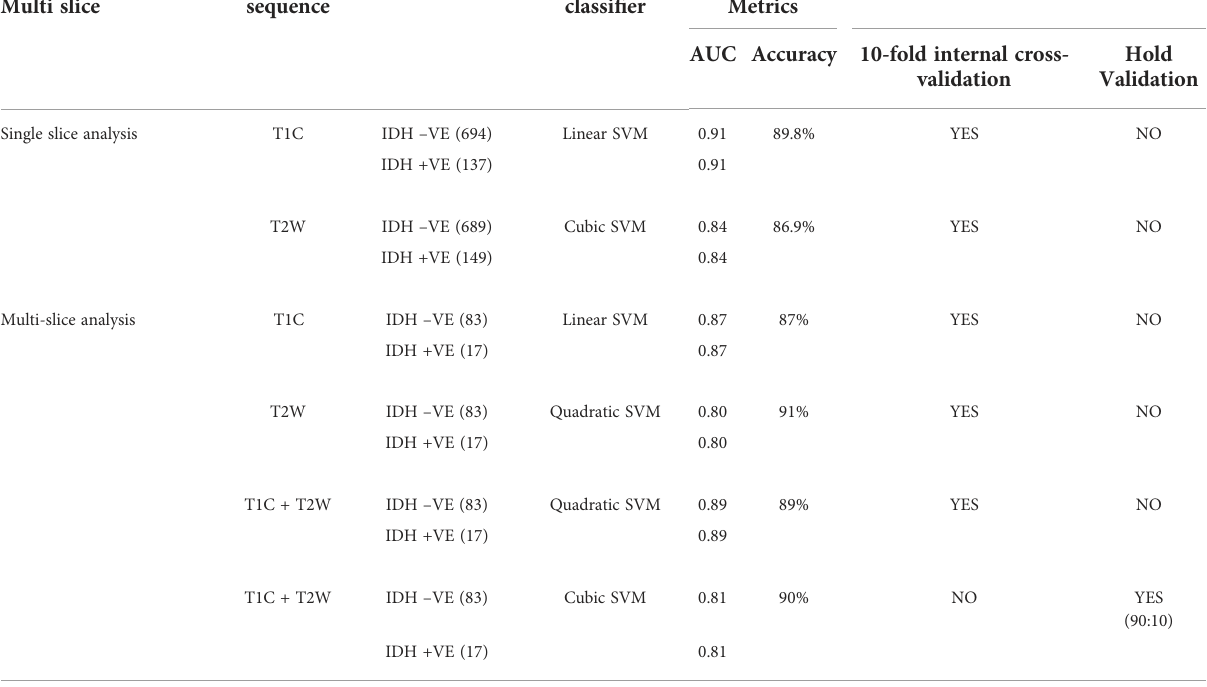
TABLE 5 Showing the molecular classi fi cation (IDH mutant and IDH wild type) of grade-IV GBM modeled by using Support Vector Machine as the radiomics classi fi er on MRI-based sequences. ImageSingle slice v/s Multi